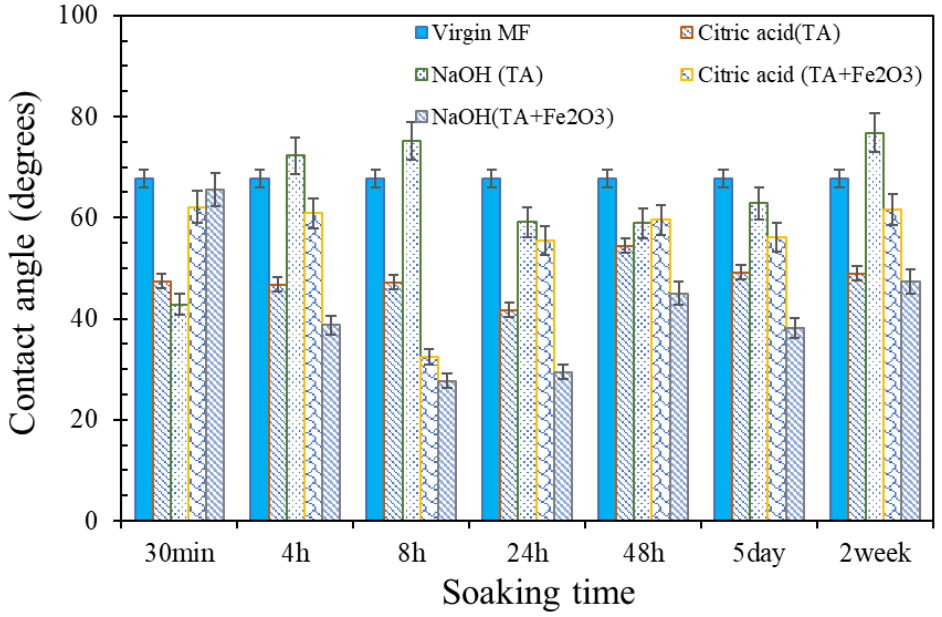
Figure A8. Contact angle of fouled MF membranes cleaned with NaOH and Citric acid of both types of wastewaters.